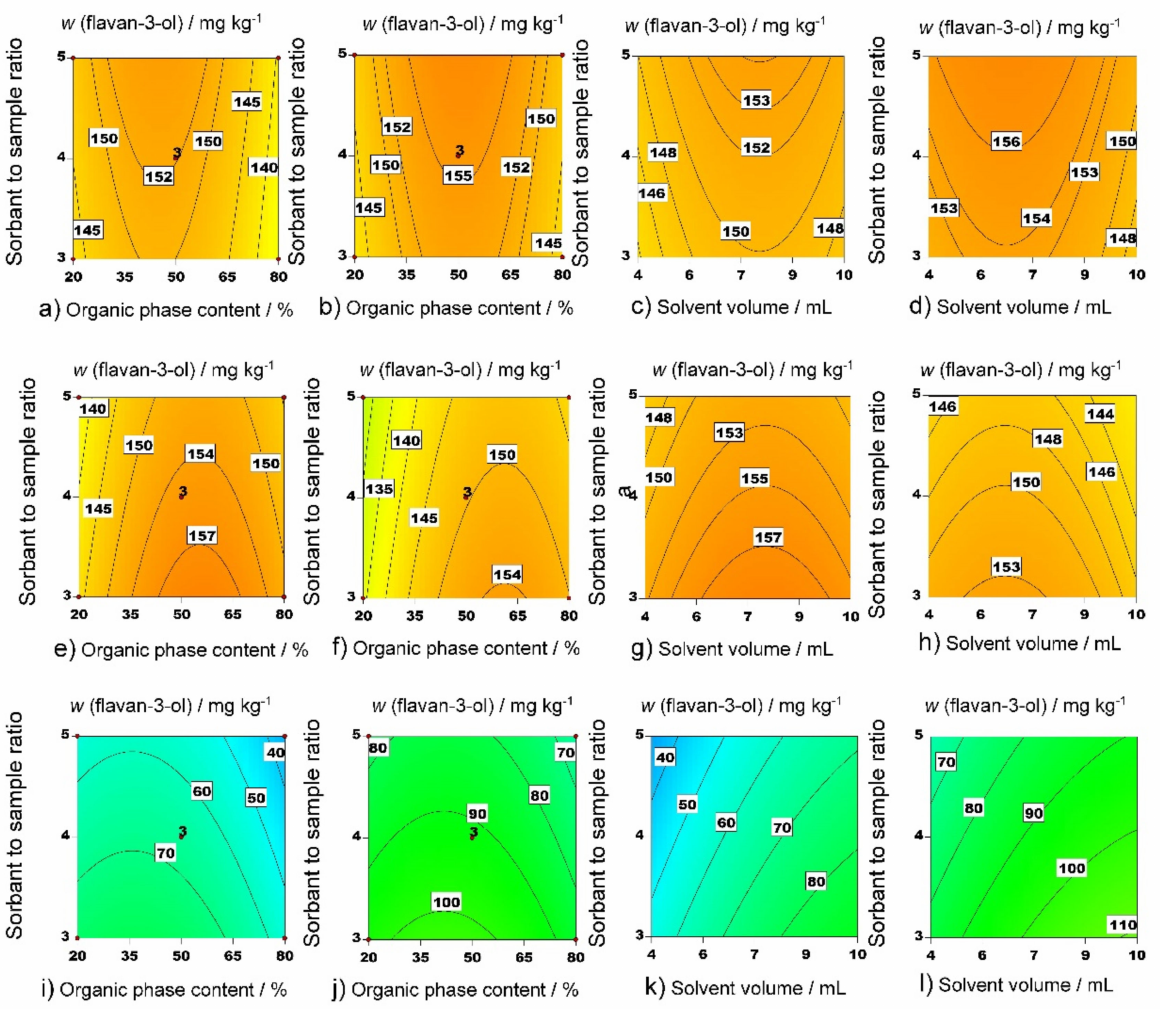
Figure 7. Contour plots of the most significant interaction effects between individual extraction factors on the content of flavan-3-ol when using ( a ) sea sand and acetonitrile and ( b ) sea sand and ethanol with an elution volume of 7 mL, ( c ) sea sand and acetonitrile and ( d ) sea sand and ethanol with a volume content of organic phase in the elution solvent of 50%, ( e ) phenyl silica and acetonitrile and ( f ) phenyl silica and ethanol with an elution solvent volume of 7 mL, ( g ) phenyl silica and acetonitrile and ( h ) phenyl silica and ethanol with a volume content of organic phase in the elution solvent of 50%, ( i ) XAD-2 and acetonitrile and ( j ) XAD-2 and ethanol with a volume of elution solvent of 7 mL, and ( k ) XAD-2 and acetonitrile and ( l ) XAD-2 and ethanol with a volume content of organic phase in the elution solvent of